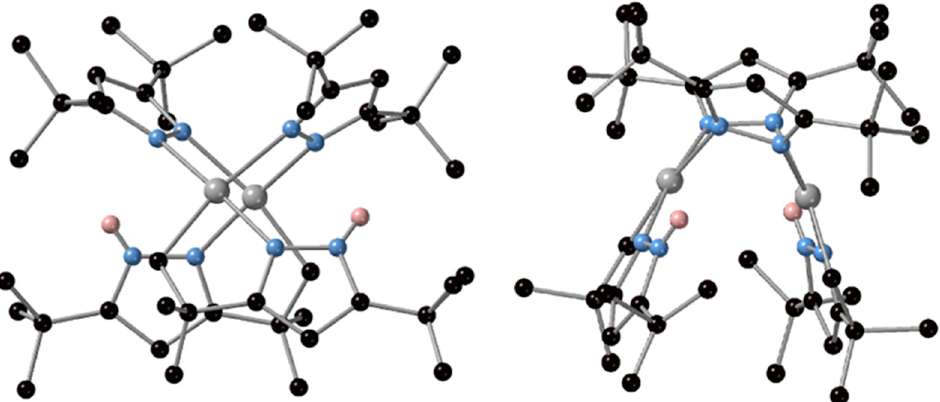
Figure 2. Two ball-and-stick views of the structure of 2 . Color code: C, black; H, pink; N, blue; Pt, grey. H atoms, except for two N-H, are not shown for clarity.